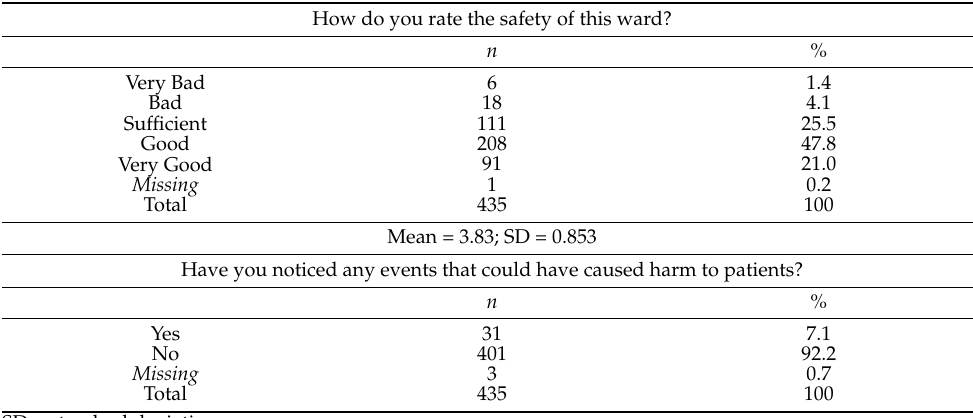
Table 4. Overall patient perception of